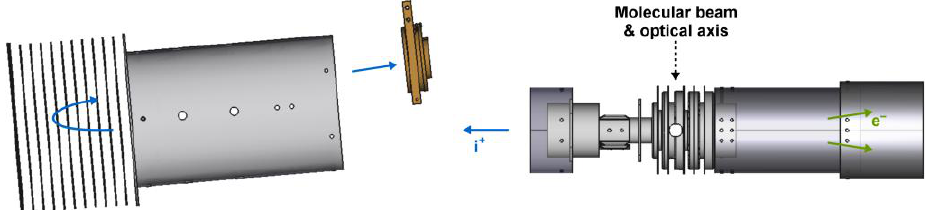
Fig. 2. Plane-view of most of the electrodes. Arrows sketch the trajectories for cations on the mass spectrometer side (left) and electrons on the velocity map imaging side (right). The total length of the spectrometer is just less than 1